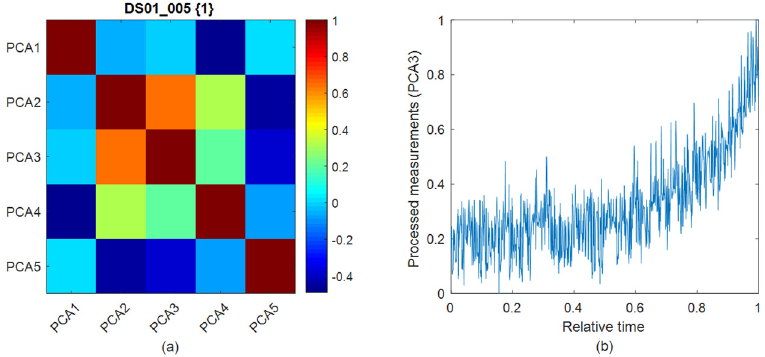
Figure 3. Correlation analysis and feature selection results: ( a ) Heatmap-based linear correlation; ( b ) Selected measurements for feeding the learning model.